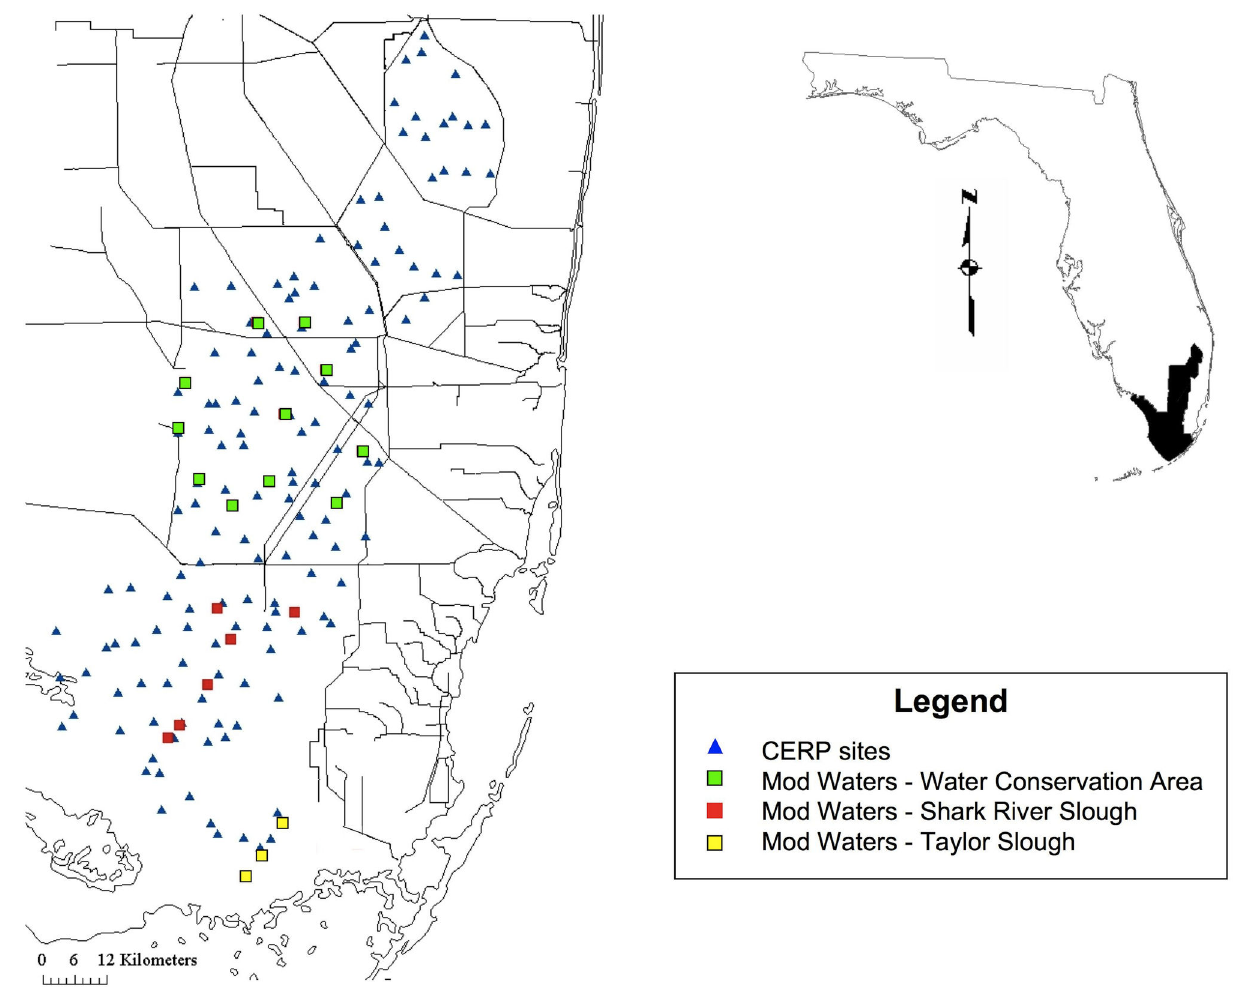
Figure 1. Mod Waters and CERP sampling sites in the Florida Everglades. CERP models were based on three years of data pooled from all sampling sites. Mod Waters models were broken down into three, six, nine, and twelve years of data. Spatial scales used were Ecosystem (all Mod Waters sites), Regions (sites within Water Conservation Area, Shark River Slough, or Taylor slough), individual sites, and plots (not shown – 100 m2 areas within each